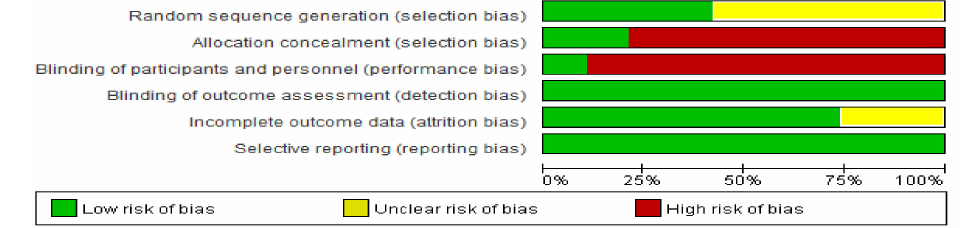
Figure 3. Methodological